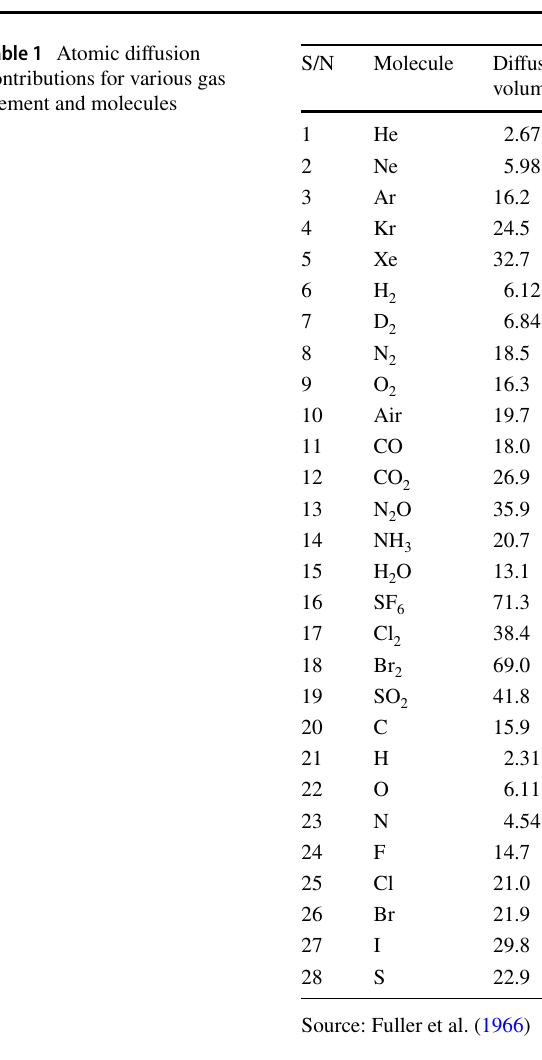
Table 2 Dimensions and petrophysical properties of Bandera grey core sample Core